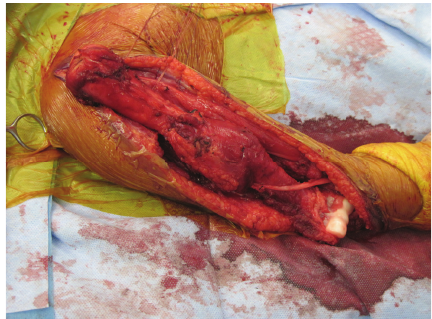
Figure 4: Total humeral surgical specimen following